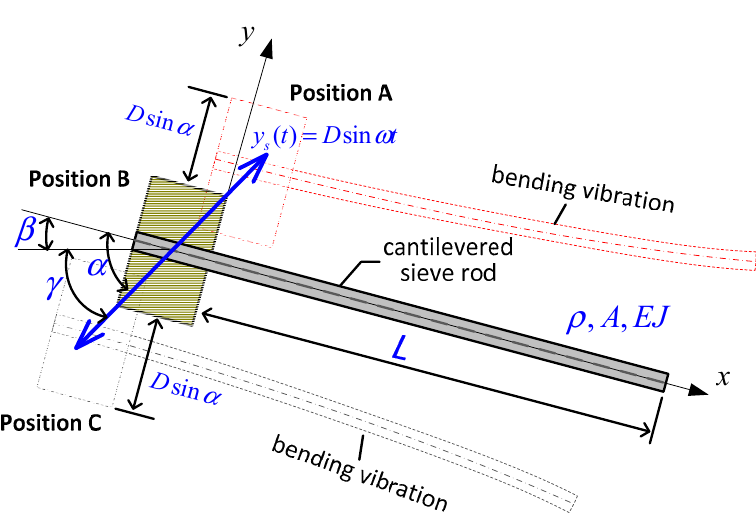
Figure 3. Cantilevered vibrating sieve (CVS) vibration model during screen body motion.